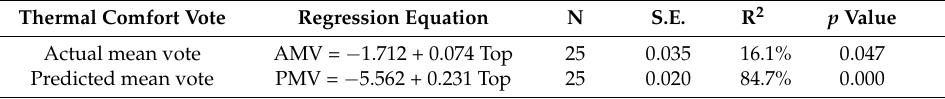
Table 5. Regression analysis of thermal comfort